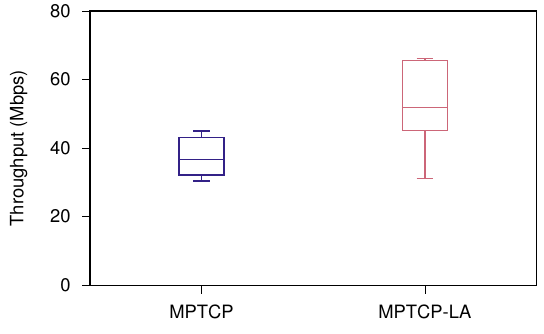
Figure 5. Throughput comparison in dynamic loss condition.